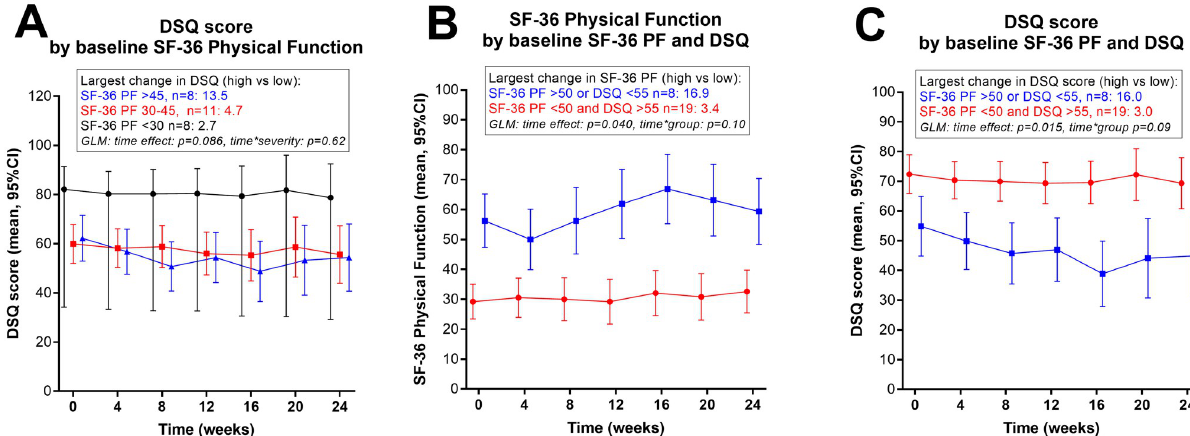
Fig 7. DSQ-SF and SF-36 Physical Function during follow-up, by ME/CFS categorized based on a combination of baseline SF-36 PF and DSQ-SF scores. (A) DePaul Symptom Questionnaire–Short Form (DSQ-SF) score (mean, 95% CI) during follow-up, by categories based on baseline SF-36 Physical Function; < 30, 30–45, and > 45. (B) SF-36 Physical function score (mean, 95% CI) during follow-up, by two groups based on: SF-36 PF > 50 OR DSQ-SF < 55 versus SF-36 PF < 50 AND DSQ-SF > 55. (C) DSQ-SF score (mean, 95% CI), by two groups based on; SF-36 Physical Function > 50 OR DSQ-SF < 55 versus SF-36 Physical Function < 50 AND DSQ-SF > 55. The largest changes in mean scores between 4-week time periods, with difference highest versus lowest, are indicated. General Linear Model (GLM) for repeated measures with p values for time effect and for interaction time-by-group are